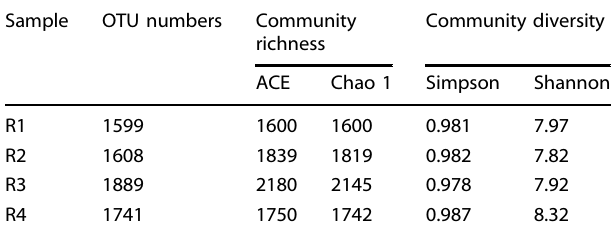
Fig. 4 The qPCR results of anammox enrichment process. a Anammox 16S rRNA copy numbers at different days (0, 60, 120, and 180) and b functional gene copy numbers of AOB, denitrifying bacterial, and anammox on day 180. Data indicate average, and error bars represent standard deviation of the results from three independent samplings, each tested in triplicate. Table 1. The OTU numbers and bacterial diversity indices of sludge